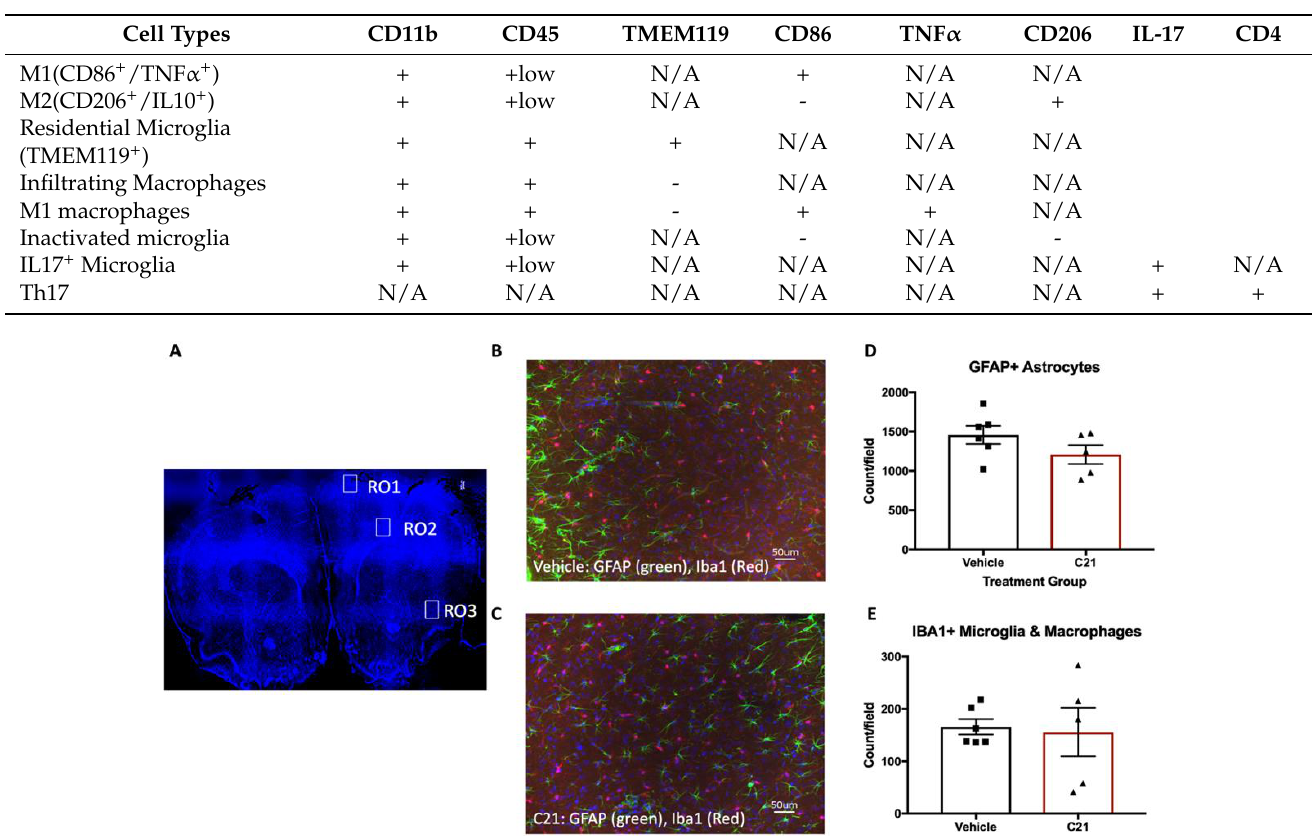
Table 1. Flow cytometry markers utilized to identify particular cell populations.